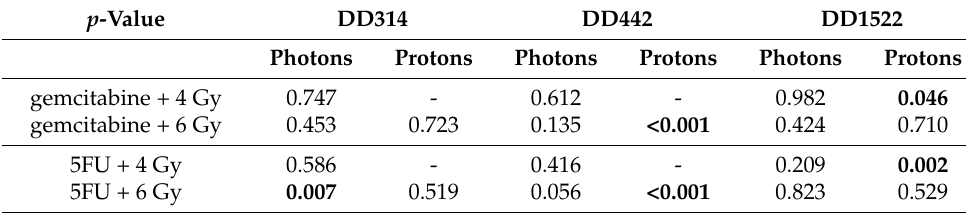
Table 3. Therapeutic effects after treatment with RCT on day